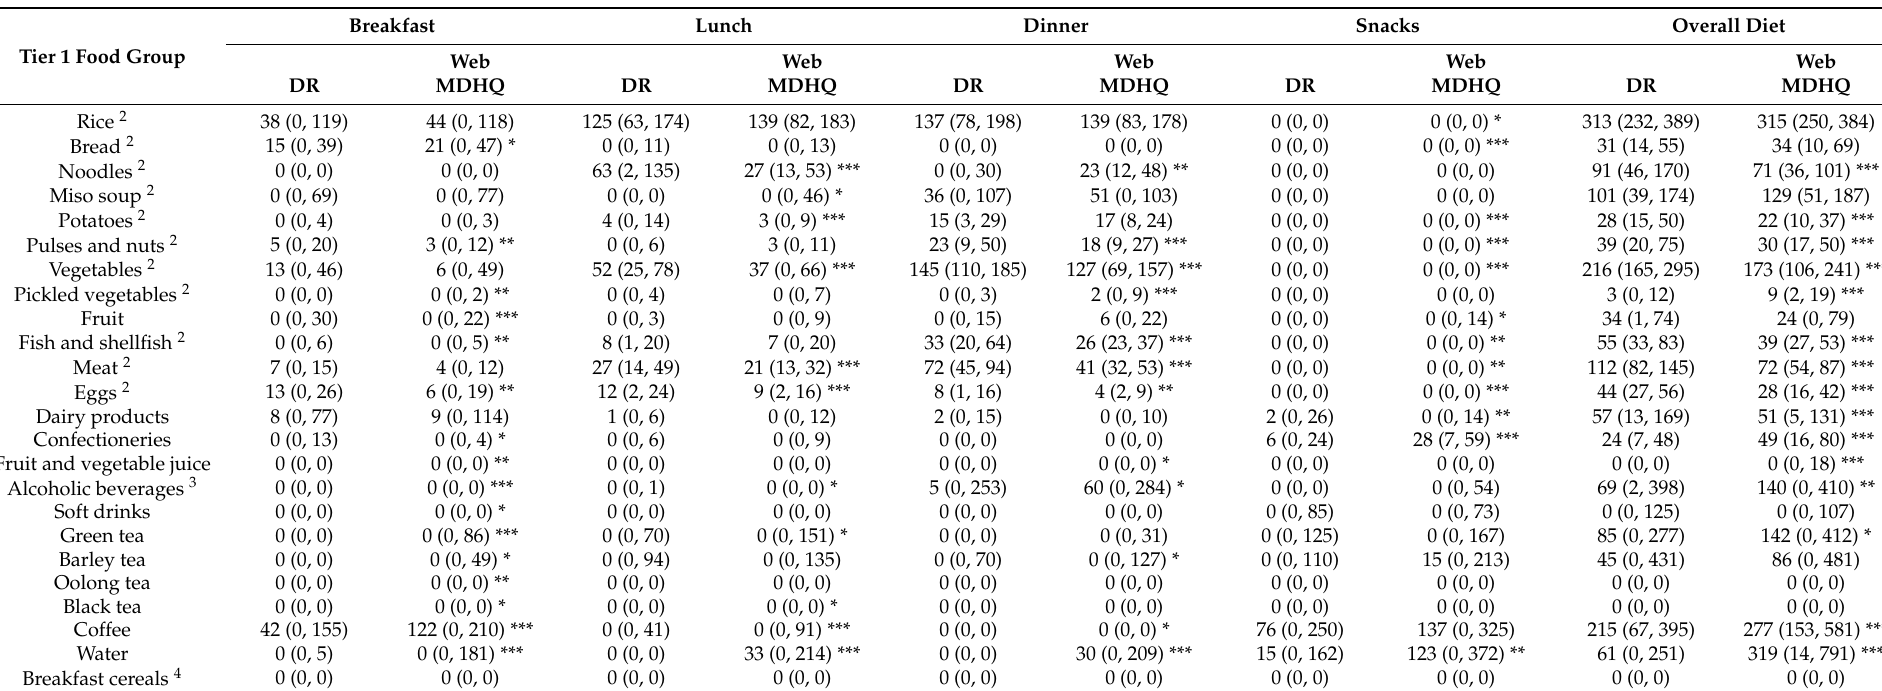
Table 3. Median estimates of daily intakes of Tier 1 food groups (in grams per day) derived from the 4-day weighed dietary record (DR) and those derived from the web version of the Meal-based Diet History Questionnaire (MDHQ) in 111 Japanese men, according to meal type 1